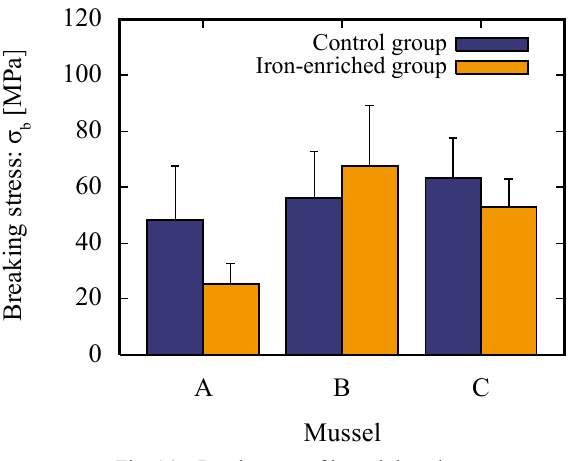
Fig. 14 Break stress of byssal threads (error bars show 95% mean confidence